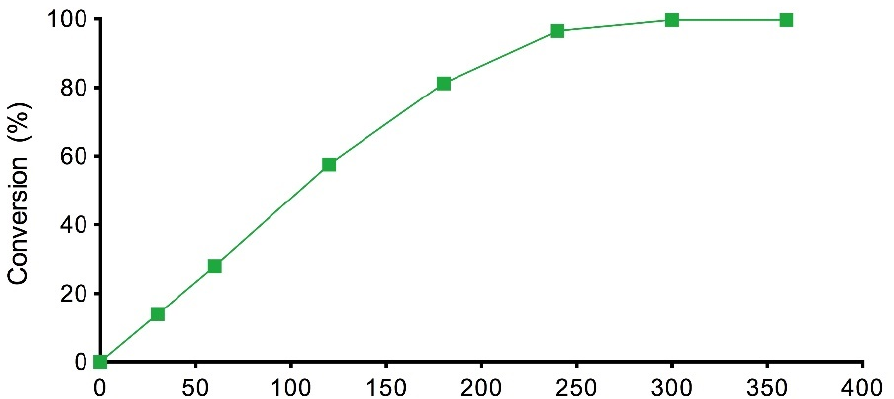
Figure 5. Conversion values of EHMH with time at 80 °C, 350 rpm, 2.5% (w/w) of biocatalyst and 20% EH molar excess (1:1.2 substrate molar